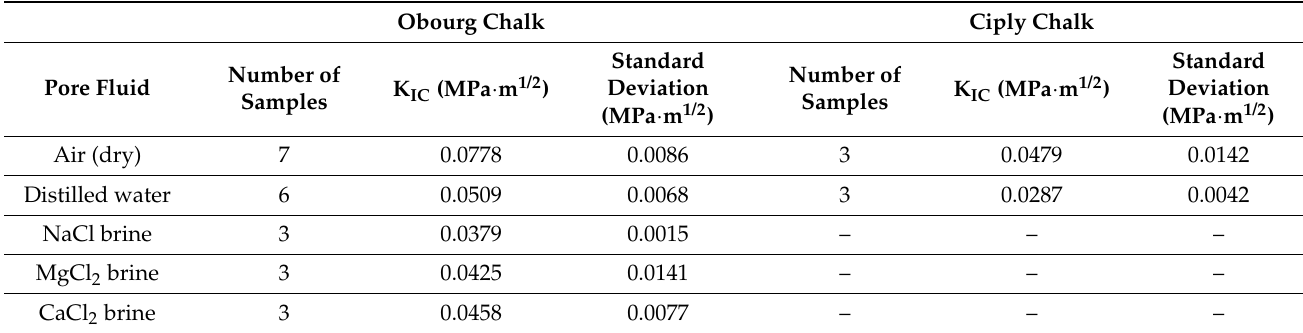
Table 5. Compilation of fracture toughness measurements for Obourg and Ciply Chalk samples saturated with different pore fluids. Obourg